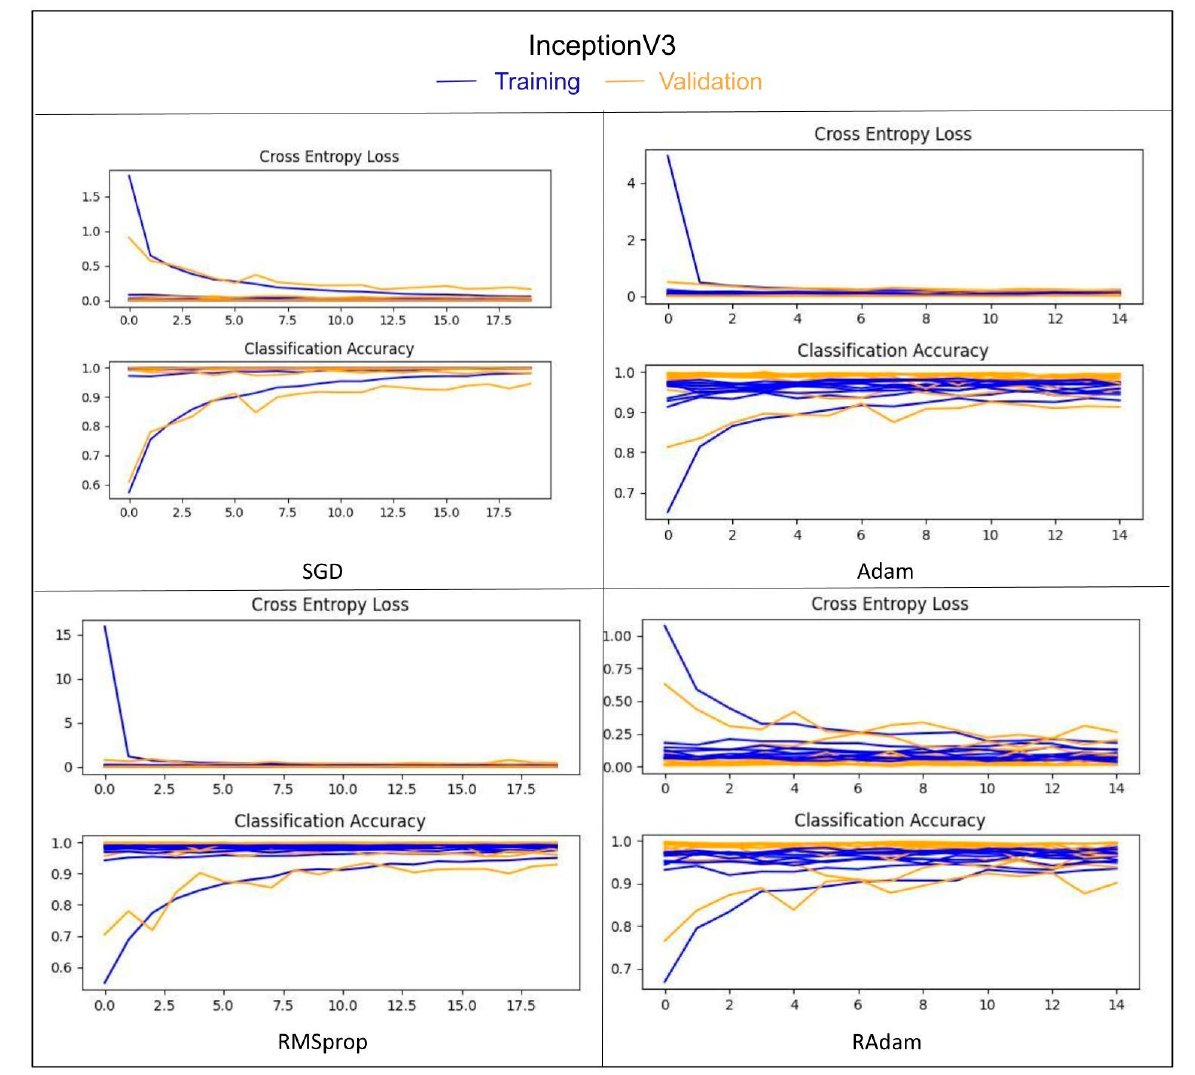
Figure 9. The convergence curves in InceptionV3 training with four optimizers. Table 5. Comparison with other approaches using UNBC-McMaster